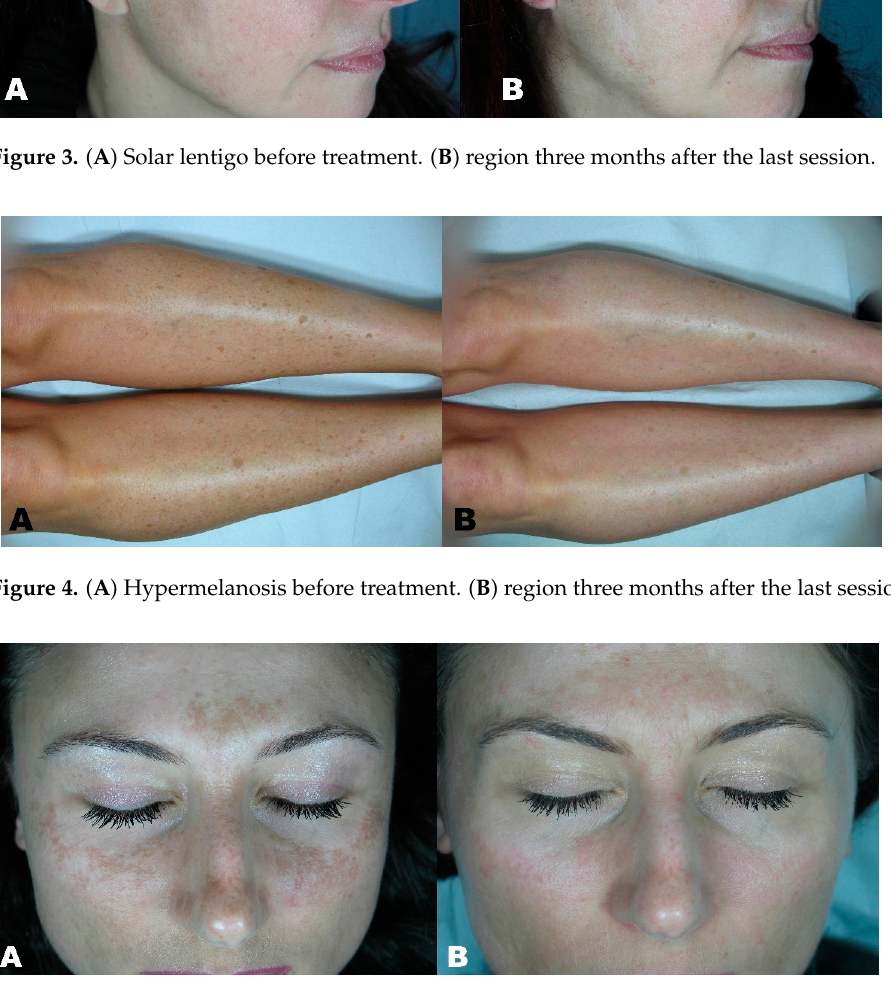
Figure 5. ( A ) Melasma before treatment. ( B ) Melasma three months after treatment.